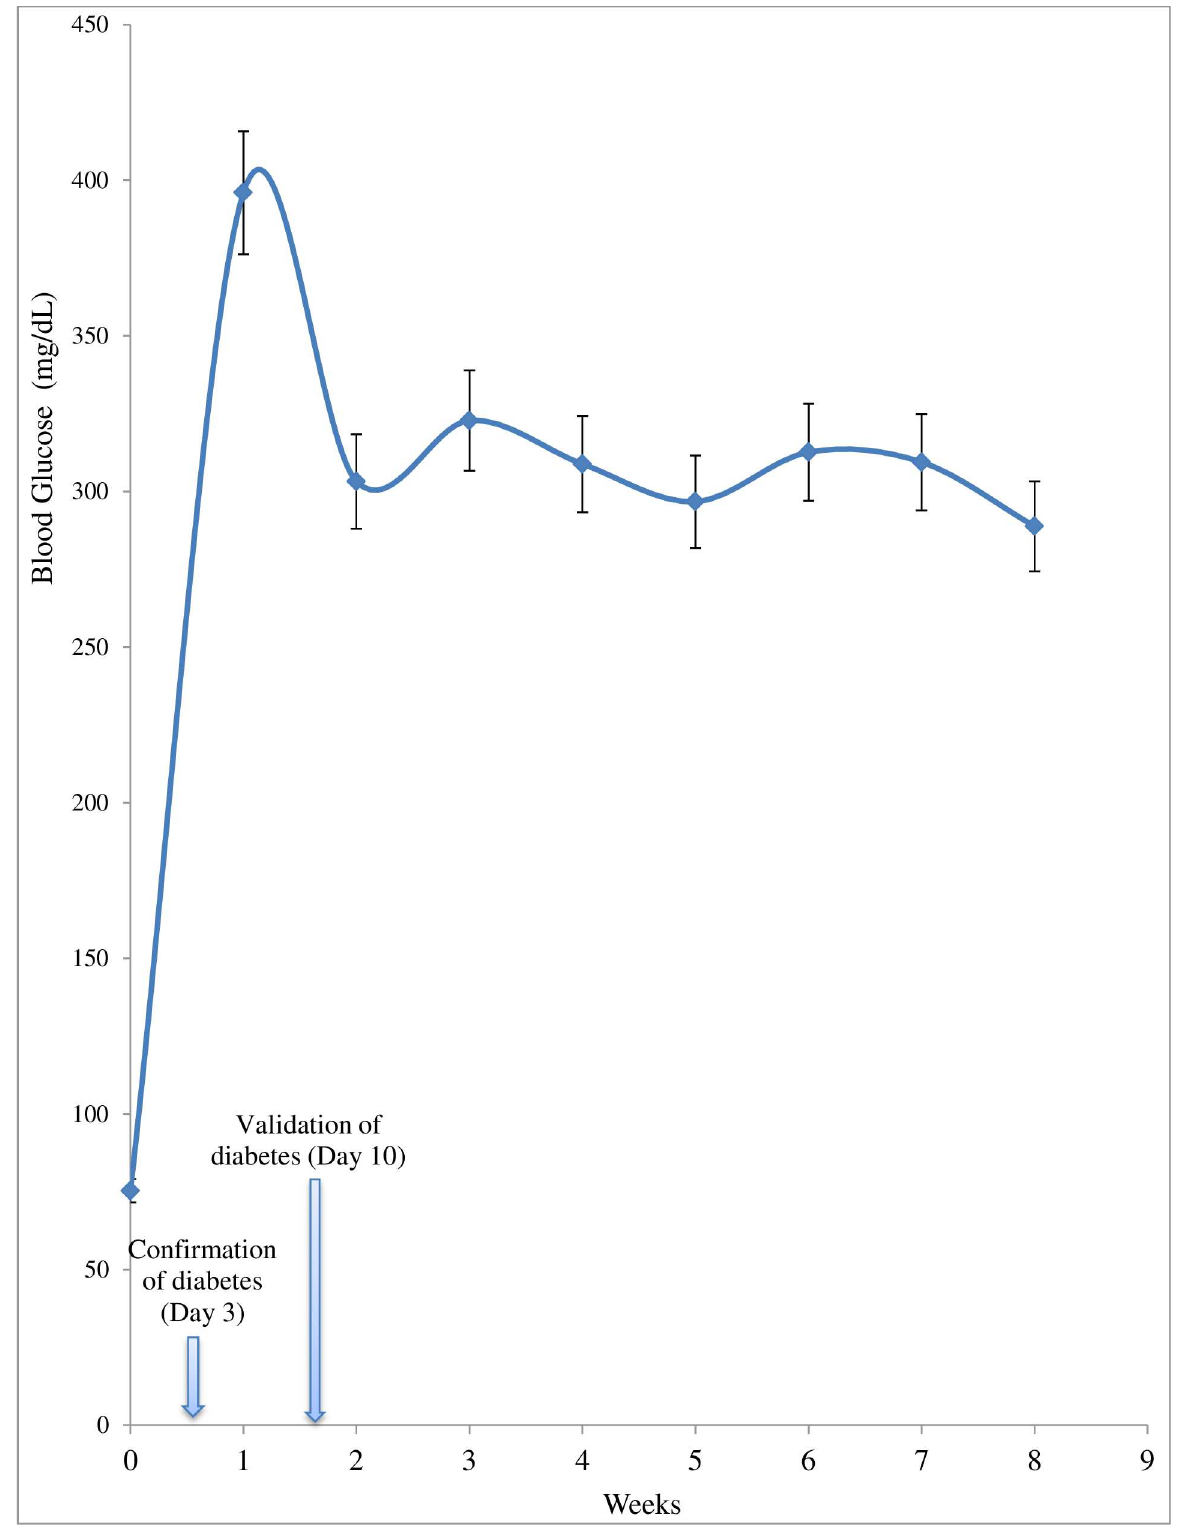
Fig 4. Non-Fasting Blood Glucose Curve in FDF 35 Rat Group from Post STZ Induction to the End of the Experiment. Data are presentedas mean ± SD of 6 animals.